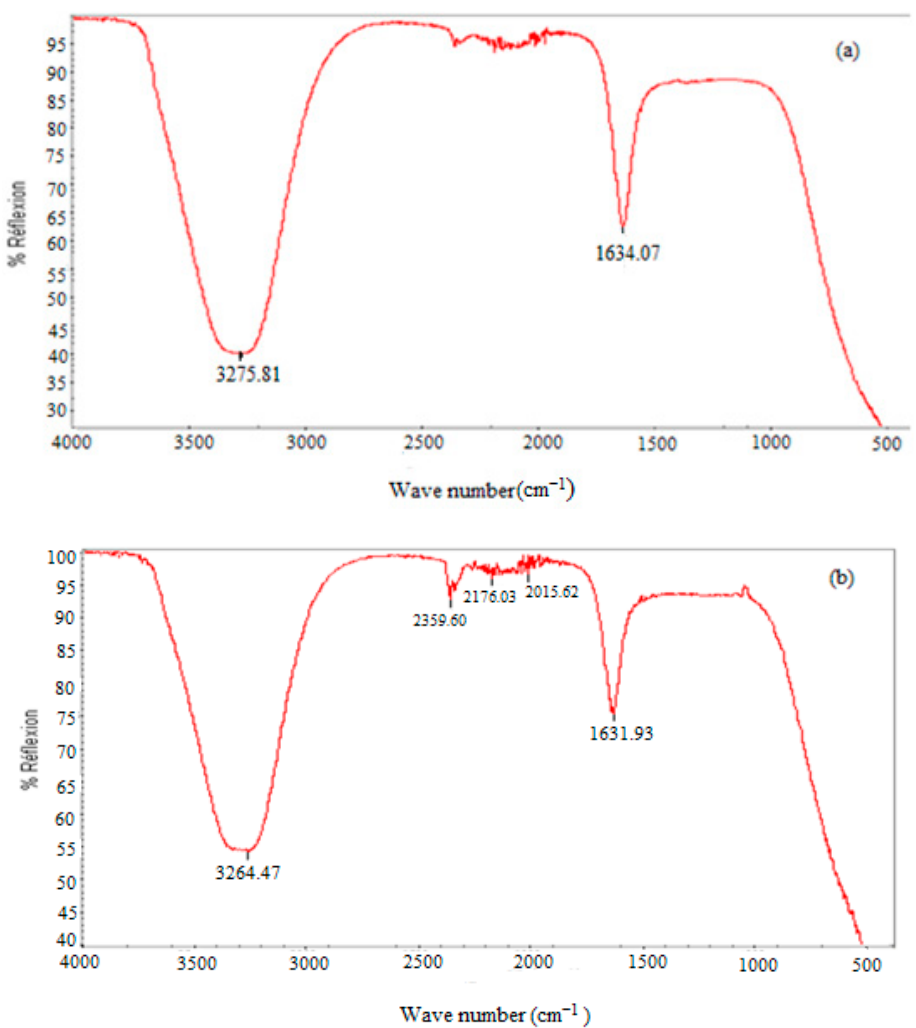
Figure 2. Spectroscopy of WAS before ( a ) and after ( b ) EF pretreatment.